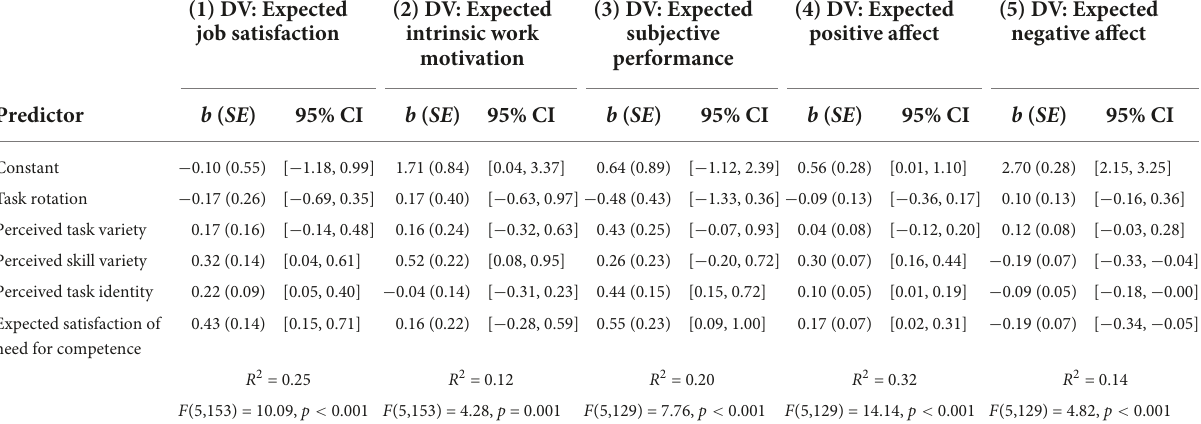
TABLE 6 Regression coefficients, standard errors, and model summary for all outcomes in Study 2.